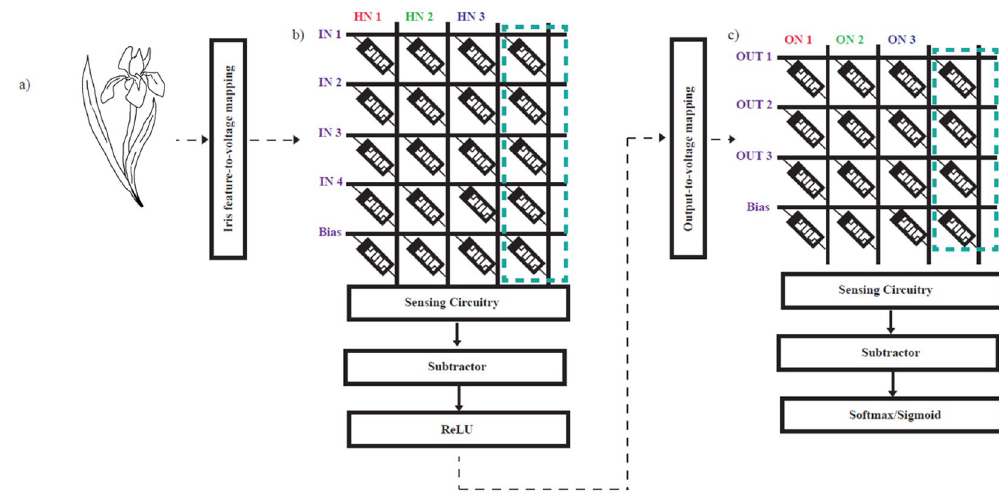
Figure 8. ANN architecture for Iris flower classification where ( a ) is the iris input that consists of the sepal and petal length and width in cm, ( b,c ) show the first and second layers of fabricated MR crossbars to accelerate the VMM of the classification task during inference phase. (HN represents the hidden neurons and ON represents the output